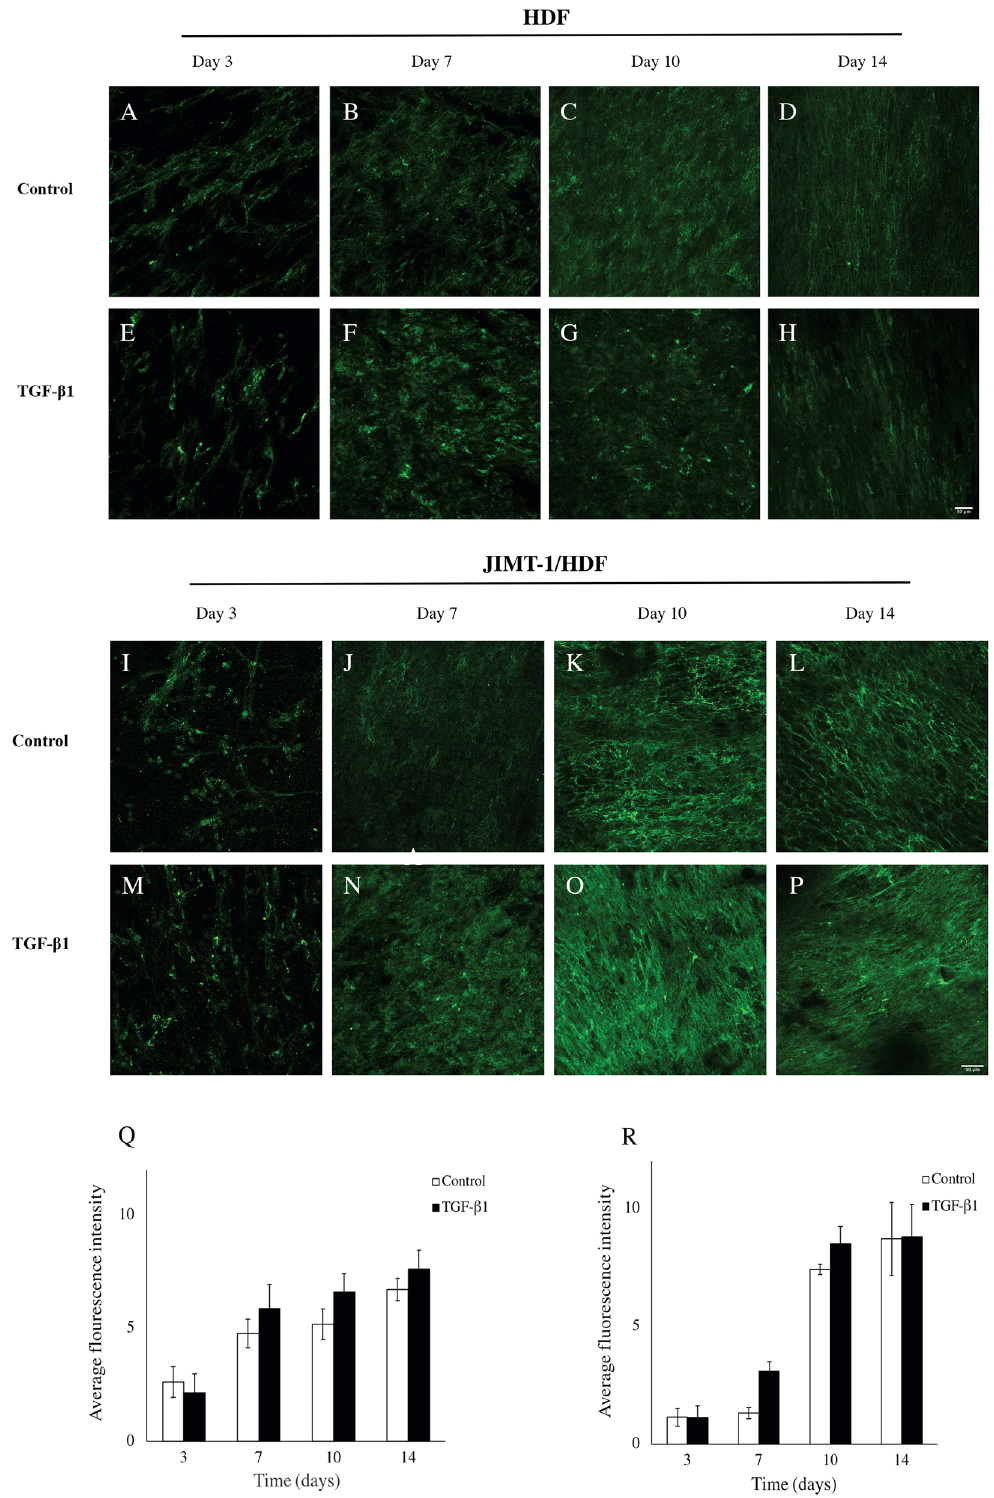
Figure 2. Collagen I deposition, localization, and quantification in decellularized scaffolds of HDF and JIMT-1/HDF 3D cultures. ( A – P ) Single confocal plane images of collagen I deposition taken in the centre of decellularized 3D cultures incubated in the absence (control) or presence of 5 ng/ml TGF-β1. The 3D cultures were decellularized, fixed in 3.7% formaldehyde and stained to visualize fibronectin (green) at 3, 7, 10, and 14 days of culturing. All images are representative of 3 independent experiments. Scale bar is 50 μm. Quantification of fluorescence intensity using ImageJ in images taken by epifluorescence microscopy in HDF decellularized scaffolds ( Q ) and JIMT-1/HDF decellularized scaffolds ( R ). The columns are represented as mean ± SEM (n =